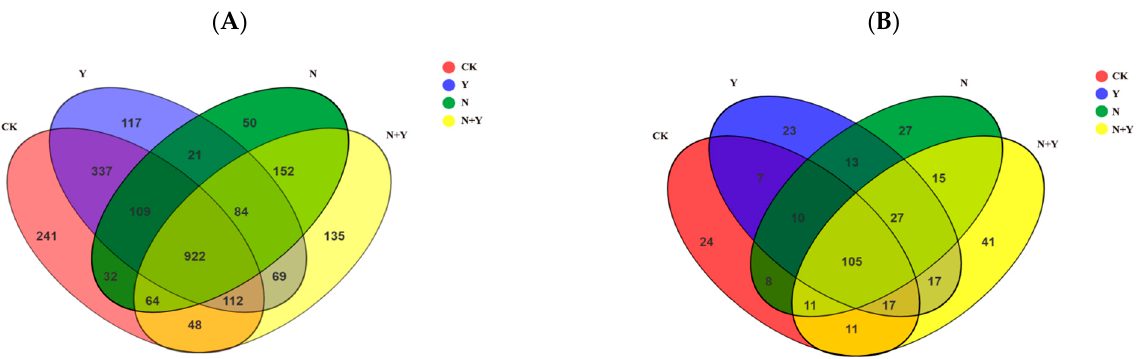
Figure 3. Venn diagrams about unique and shared OTUs of samples collected from different treat- ments. Different treatments: CK (control), seedlings were irrigated with normal nutrient solution; Y, control + B. subtilis K424; N, four-strength control; N + Y, four-strength control + B. subtilis . K424 ( A ) bacteria; ( B ) fungi.